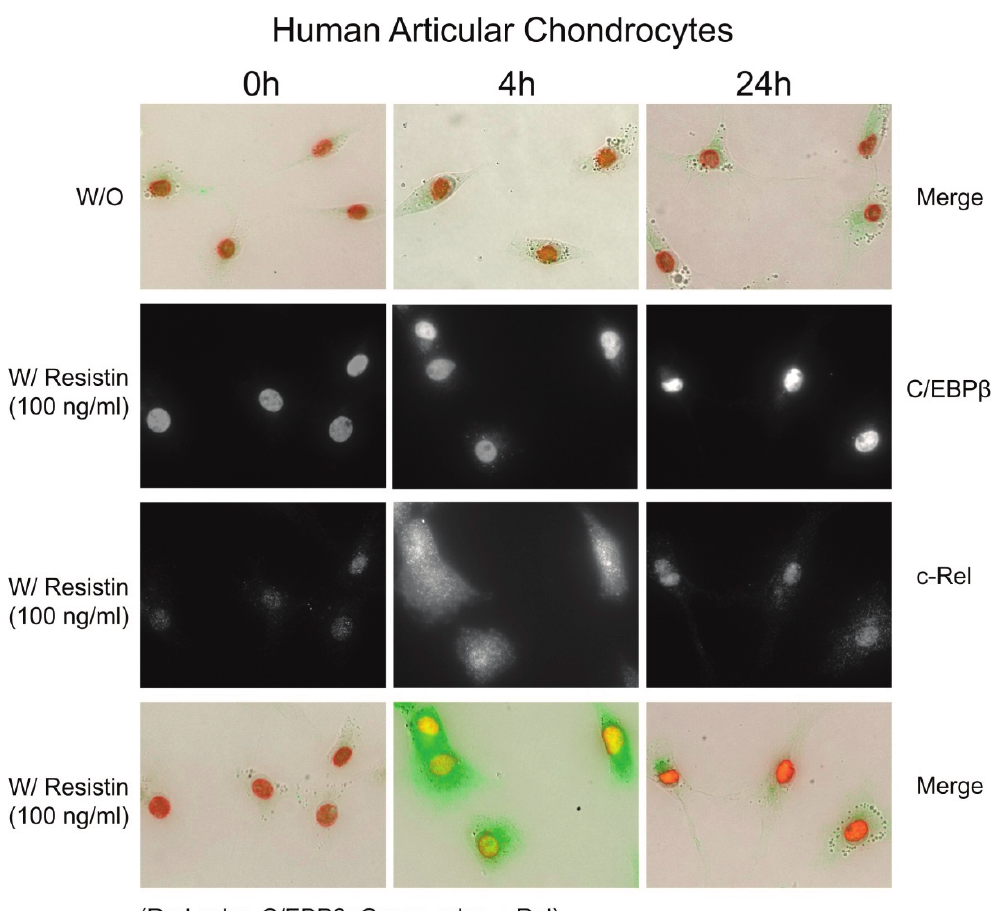
panel shows a merged image of immunohistochemistry for C/EBP β and the NF- κ B subunit c-Rel : C/EBP β is present in the nucleus of cells even without resistin exposure, while c-Rel is located diffusely throughout the cell. With addition of resistin , C/EBP β is increased in the nucleus and c-Rel is increased and translocates to the nucleus. At 24 h, C/EBP β remains high in the nucleus and c-Rel is significantly